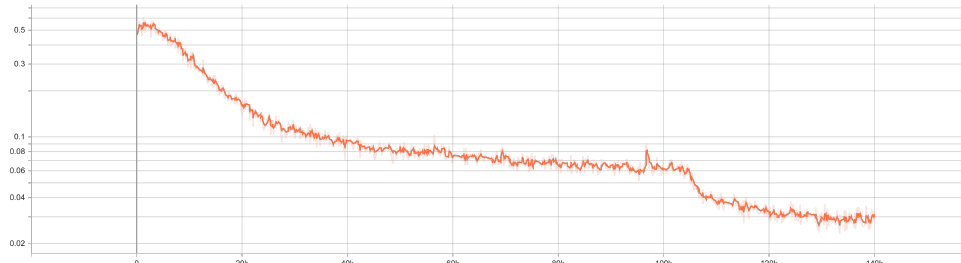
Figure 10. Loss value measurement in the training process of the Student model.